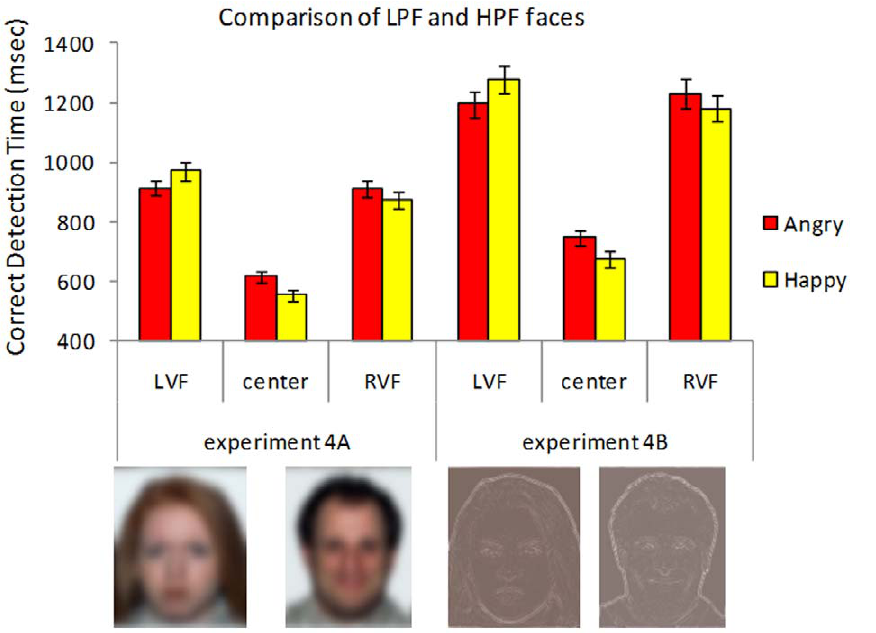
Figure 3. Reaction times to correctly identify the stimulus as a function of the type of dynamic expression (becoming angry vs. becoming happy), its location, and whether it was high or low pass filtered. Standard error bars are included to provide a sense of variability across subjects, but do not correspond to the within-subjects hypothesis tests reported in the text.